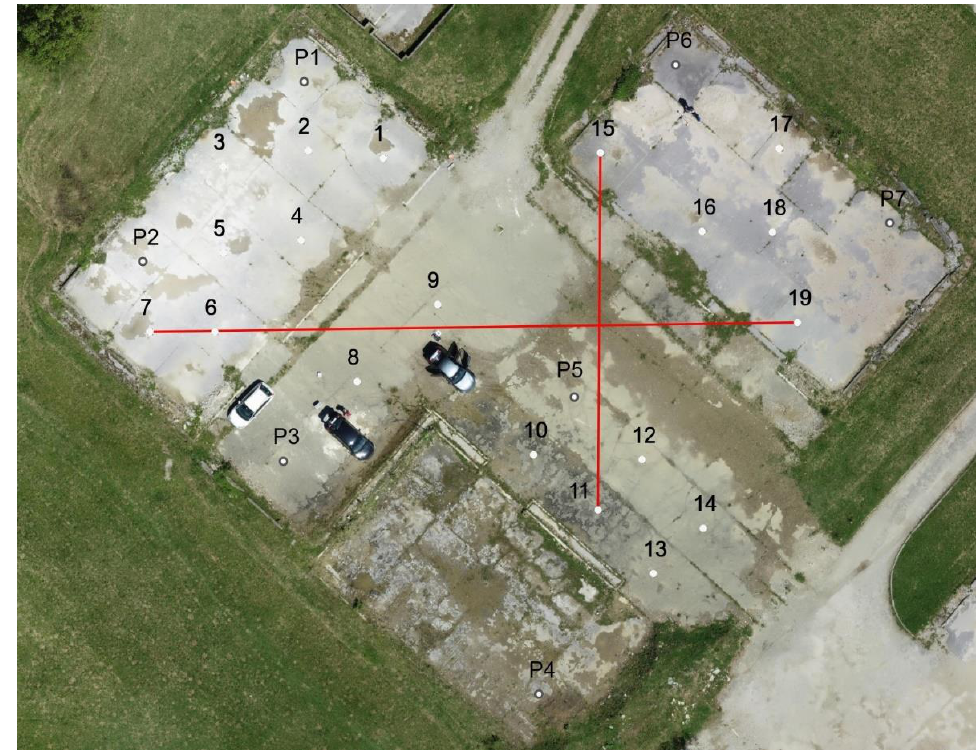
Figure 11. Selected distances between points. Table 10. Calculated map scales